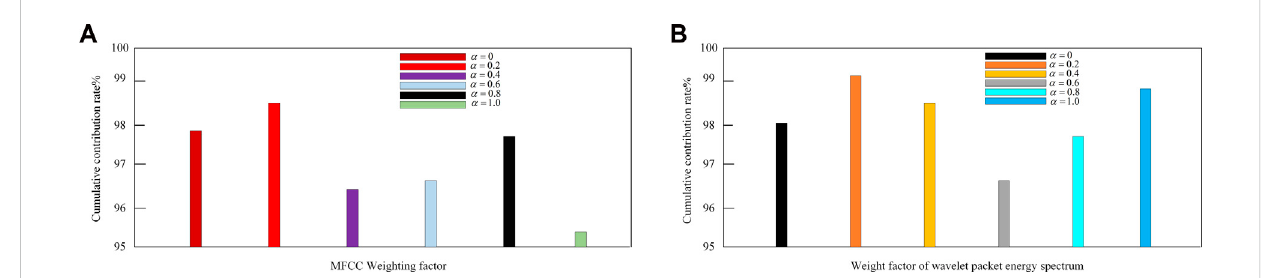
FIGURE 7 Cumulative contribution rate of WPES and MFCC comprehensive characteristic parameters with different weight factors.